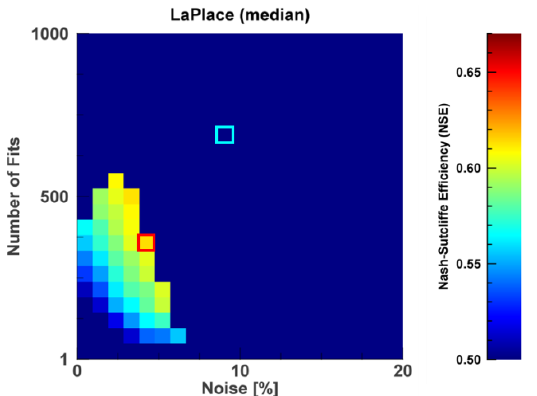
Figure 4. Accuracy matrix for the Laplace/median combination based on inverse-multiplicative noise after the rejection threshold for slope (0.8 ≤ m ≤ 1.2) and intercept (≤1.00) was applied. The red-marked square shows the combination with the highest accuracy (σ = 4%, n = 350), which resulted in a value for NSE of 0.62 after the exclusion of inappropriate combinations due to the thresholds. For comparison, the blue-marked square shows the position of the formerly identified ideal criteria combination, which had been derived without taking slope and intercept of the regression into